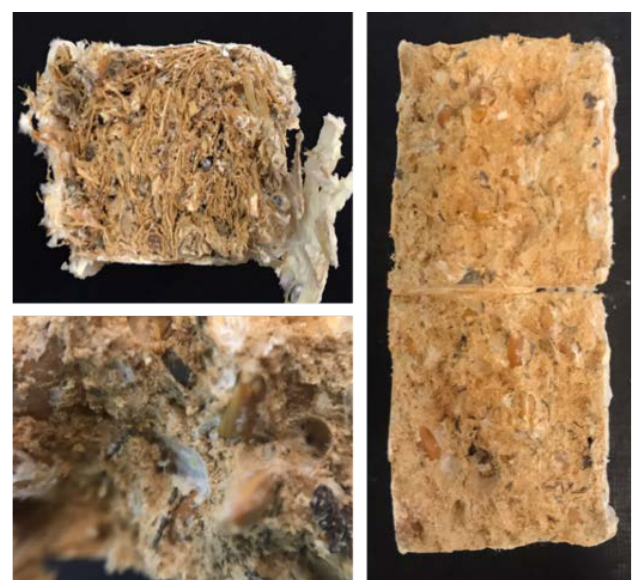
Figure 24 Cross-Sections of Samples from Experiments 2 and